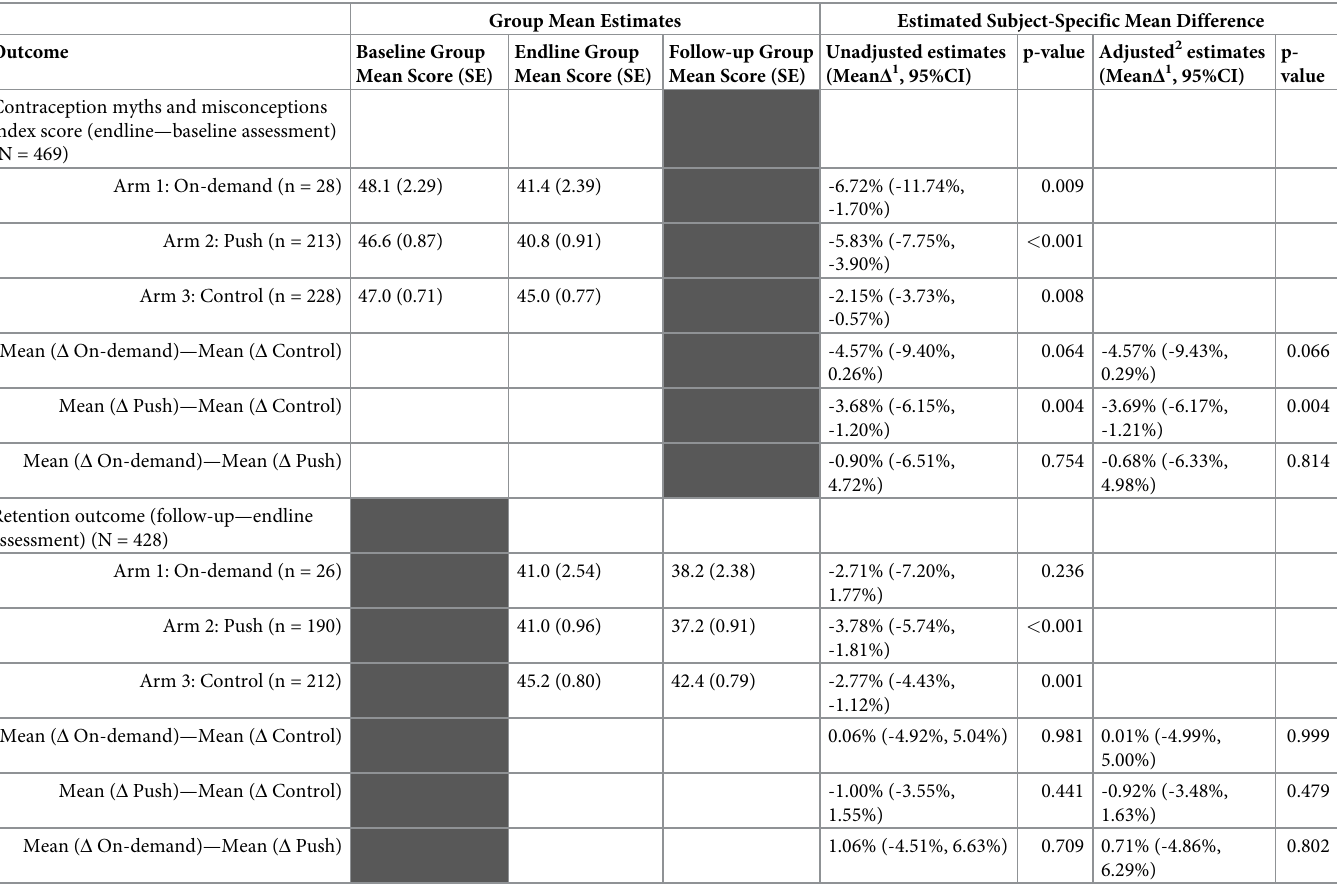
Table 3. Analysis of primary and secondary outcomes for per-protocol (PP) analysis. Female and male 13–17 year olds, San Juan de Miraflores, Lima,